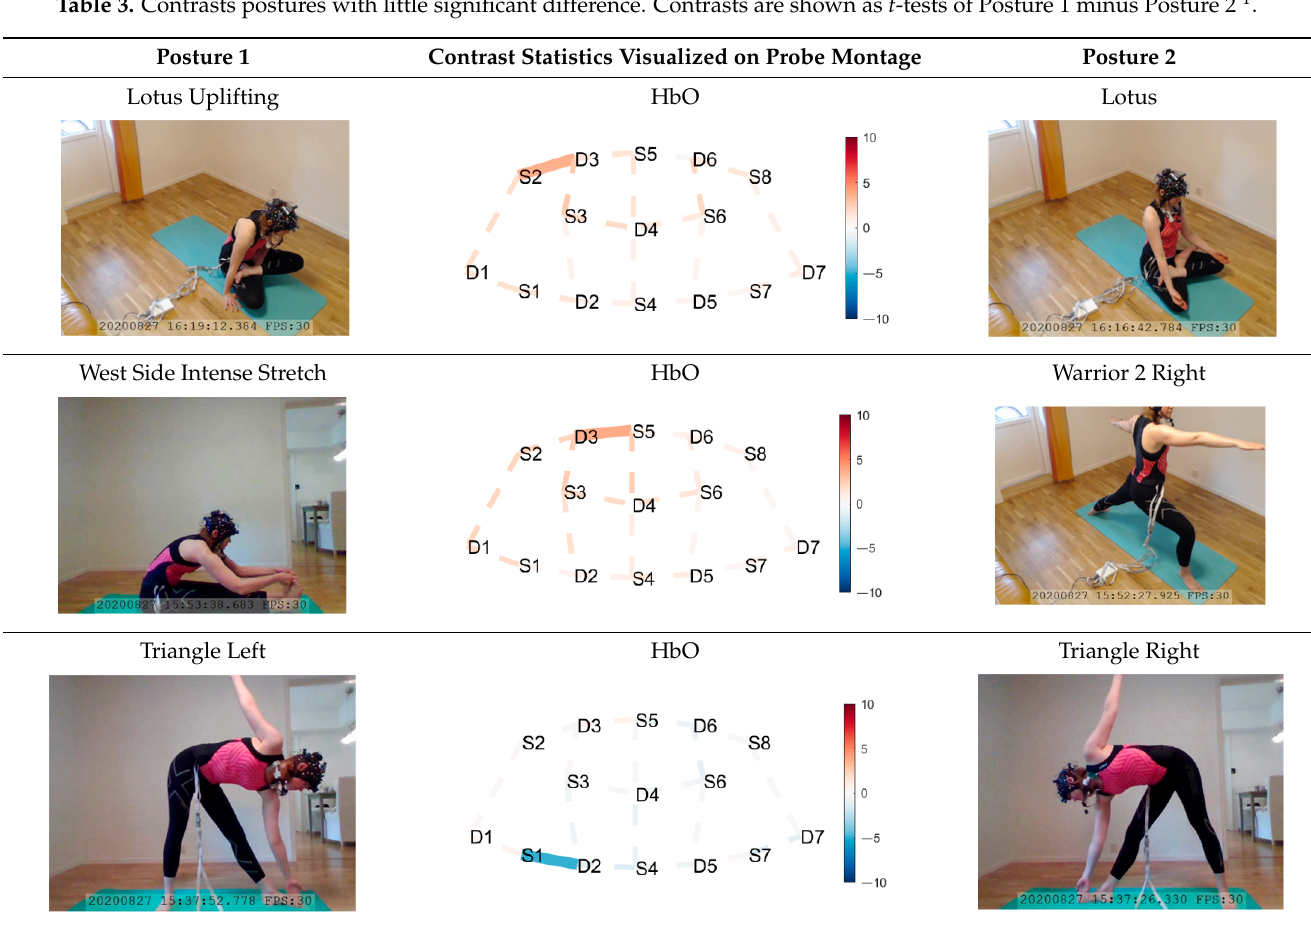
1 Second-level analysis of HbO and HbR changes for selected contrasts; t-statistic maps with significantly different brain activation (q < 0.05) in solid lines; color bar represents the t-statistic (scaled to range [ − 10, 10]) with red/blue indicating statistical increase/decrease in HbO concentration between the postures.